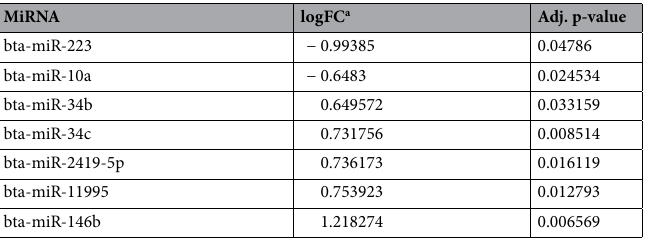
Table 1. Differentially expressed miRNA in the testes of Holstein–Friesian dairy bull calves fed differentially up to 12 weeks of age. a Positive logFC value indicates up-regulation and negative indicates down-regulation in the HI group compared to the MOD